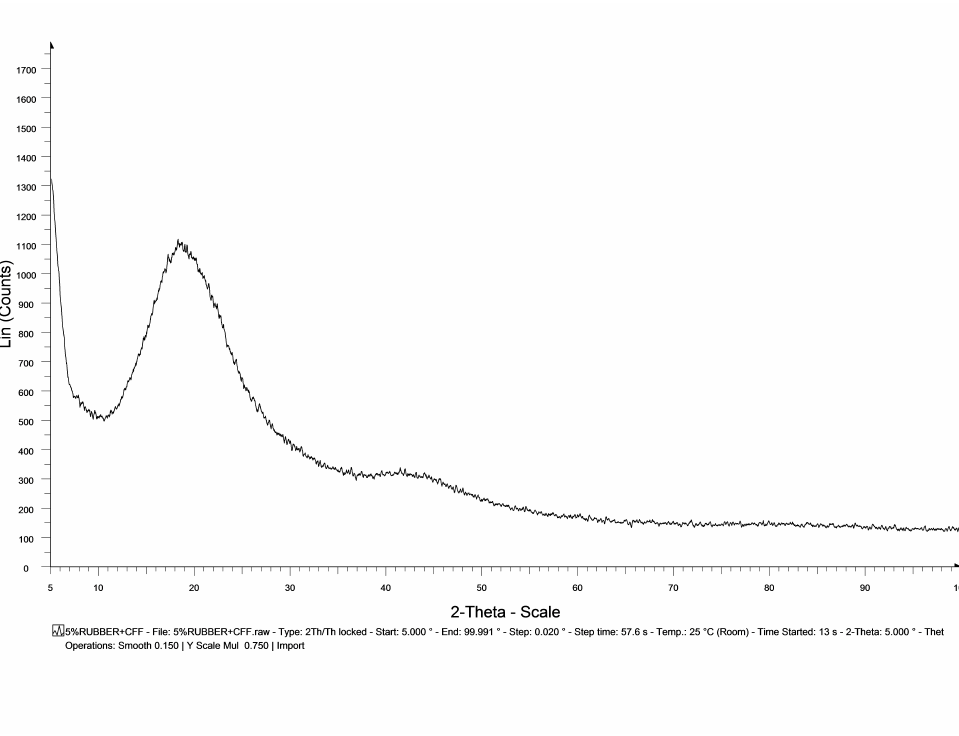
Figure 31: XRD for the sample containing 2.0 wt% CR and 5.0 wt% CFF.